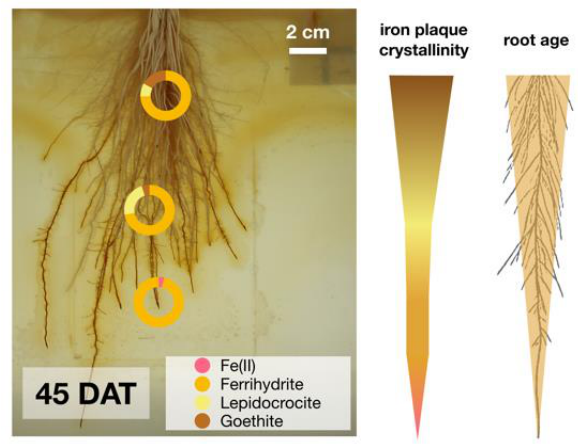
Figure 4. Iron plaque collected from different root sections, young root tip, middle part (approx. 20 days old) and basal root zone (approx. 40 days old) showed increasing iron mineral crystallinity which correlated positively to root age.